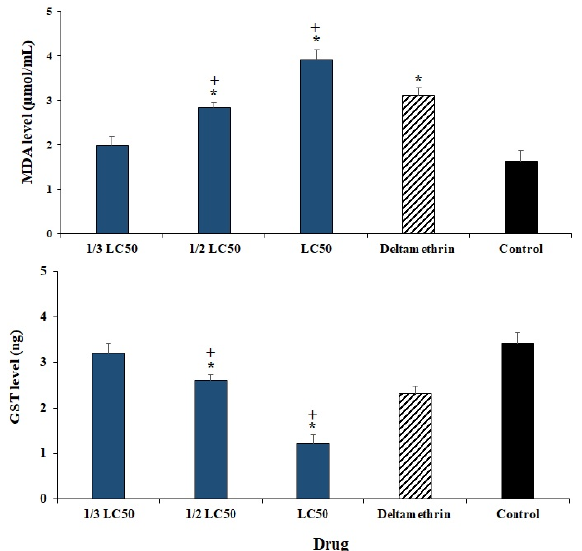
Figure 6. The effect of Elettaria cardamomum L. essential oil (ECEO) on the malondialdehyde (MDA) and Glutathione S-transferases (GST) of Hyalomma anatolicum larvae . LC 50 : the lethal concentration 50. Data are stated as mean ± SD (n = 3). * p < 0.001 significant difference with control group; + p < 0.001 significant difference with deltamethrin.